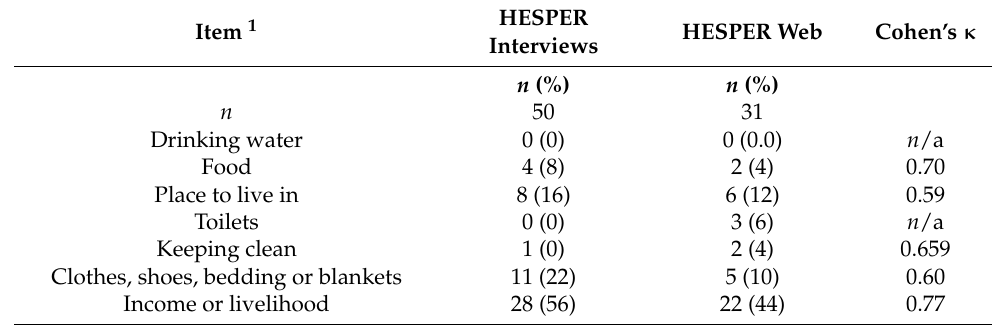
Table 2. Persons reporting specific needs and Cohen’s κ between the HESPER and HESPER Web, per